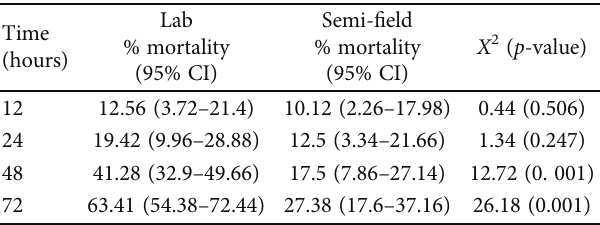
Table 3: Mortality e ff ect over time in both laboratory and semi- fi eld environment for An. arabiensis larvae.